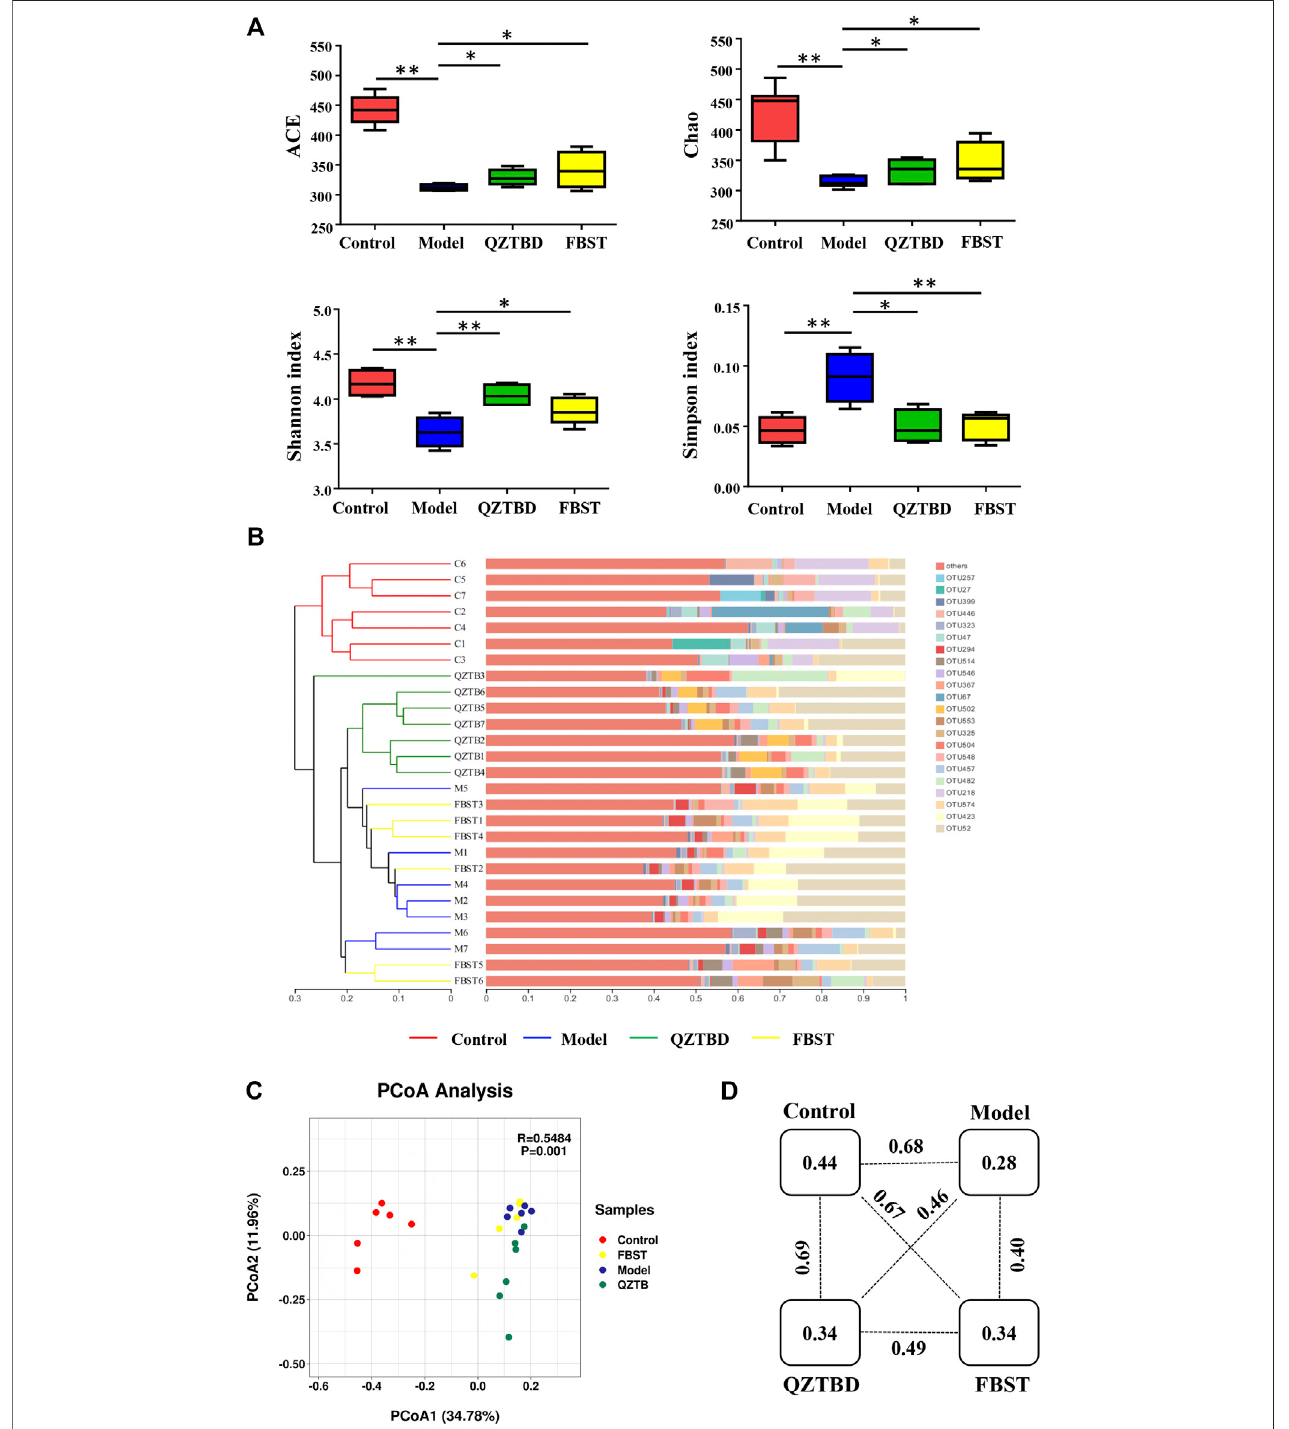
FIGURE3| QZTBD regulatedthemicrobialcommunitystructure.Effects ofQZTBD onmicrobialrichnessand diversity (A) ;HierarchicalclusteringanalysisonOTU level (B) ; PCoA score plots (C) and distance between the two groups (D) based on Bray-Curtis dissimilarities. “ * ” represents p < 0.05; “ ** ” represents p < 0.01. N (cid:2) 7/group.